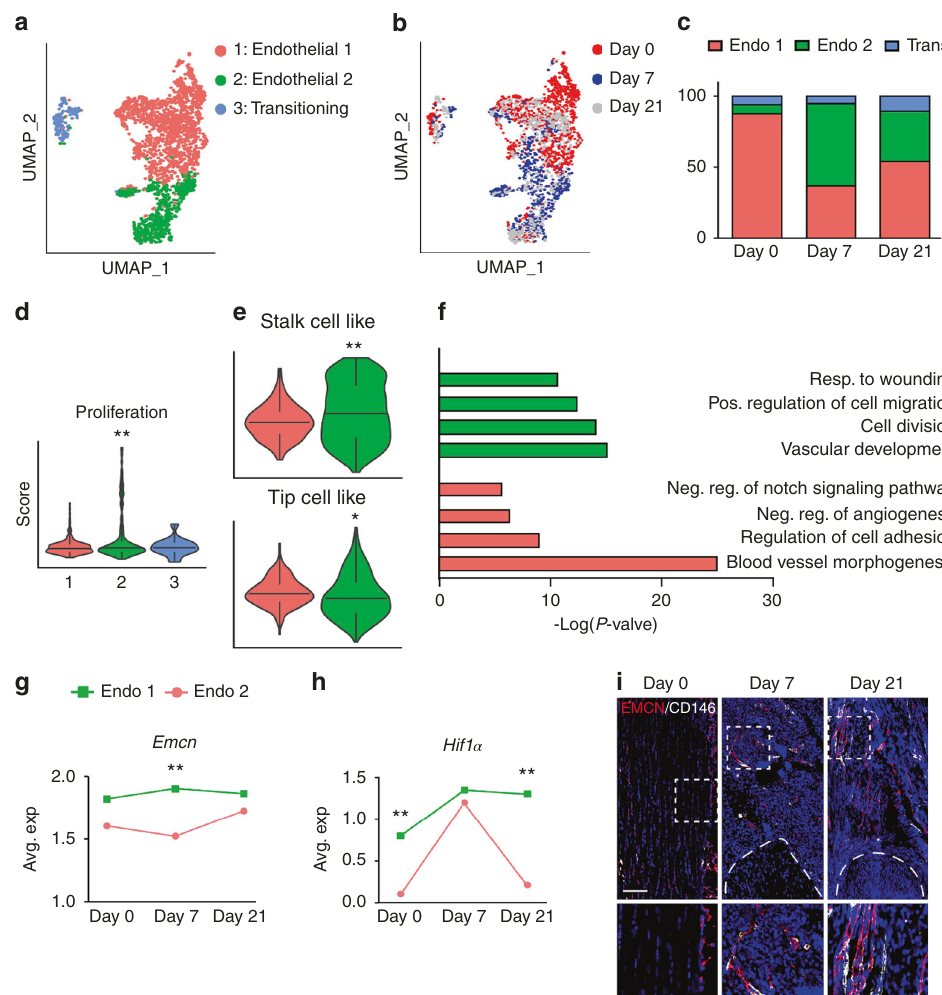
Fig. 2 Endothelial cell subclustering reveals distinct cell populations after soft tissue trauma. a – h ScRNA-seq analysis of pooled endothelial cells from the HO induction site at 0, 7 and 21 days post-injury. a, b UMAP visualization of all endothelial cells demonstrating ( a ) endothelial subclusters, and ( b ) cells across time (day 0, day 7, and day 21). c Percentage of endothelial cell subclusters across time. d Cell proliferation index across endothelial cell subclusters as determined by modular scoring, day 7. e Modular index scoring of stalk cell-like and tip cell-like phenotypes in endothelial subclusters. Gene lists for modular scores are shown in File S1. f GO term analysis of endothelial 1 and endothelial 2 subsets, based on differentially expressed genes between the groups. g Emcn expression among endothelial sub-clusters across time. h Hif1 α (Hypoxia-inducible factor 1-alpha) expression among endothelial sub-clusters across time. i Representative immuno fl uorescent staining of EMCN (Endomucin) and CD146 within the tendon injury site at day 7 and 21 in relation to uninjured control (D0). Dashed white lines indicate edges of Achilles tendon. Scale bars: 100 μ m. For histology, n = 4 animals per timepoint. For scRNA-Seq, n = 3 animals per timepoint. * P < 0.05; ** P < 0.01 in relation to endothelial subcluster 1. For two groups, non-parametric data was analyzed using the Kolmogorov – Smirnov test ( e , g , h ). For more than two groups, Non-parametric data was analyzed using the Kruskal – wallis with Dunn ’ s multiple comparison test ( d neurectomy led to a 90.1% reduction in nerve fi ber frequency at the HO site (Fig. 3a, 21 d post-injury, assessed by TUBB3 immuno fl uorescent staining). Next, CD31 immuno fl uorescent staining showed a similarly dramatic reduction in vascularity after sciatic neurectomy (Fig. 3b, 92.4% reduction in CD31 immunos- taining in comparison to sham control). To further understand the transcriptomic changes in vascular cells with or without intact innervation, re-analysis of our prior scRNA-Seq data was performed in which HO induction was performed combined with or without sciatic neurectomy, and cells of the HO site were analyzed at 7 days after injury (GSE163446). 6 Of a total of 16 823 cells, 3 616 vascular cells were captured and distributed across 4 subclusters with strong similarity to the previously analyzed dataset, including endothelial cell 1, endothelial 2, pericytes, and again a ‘ transitioning ’ cluster with markers shared between endothelial and pericytes (Fig. 3c, d). Consistent with prior